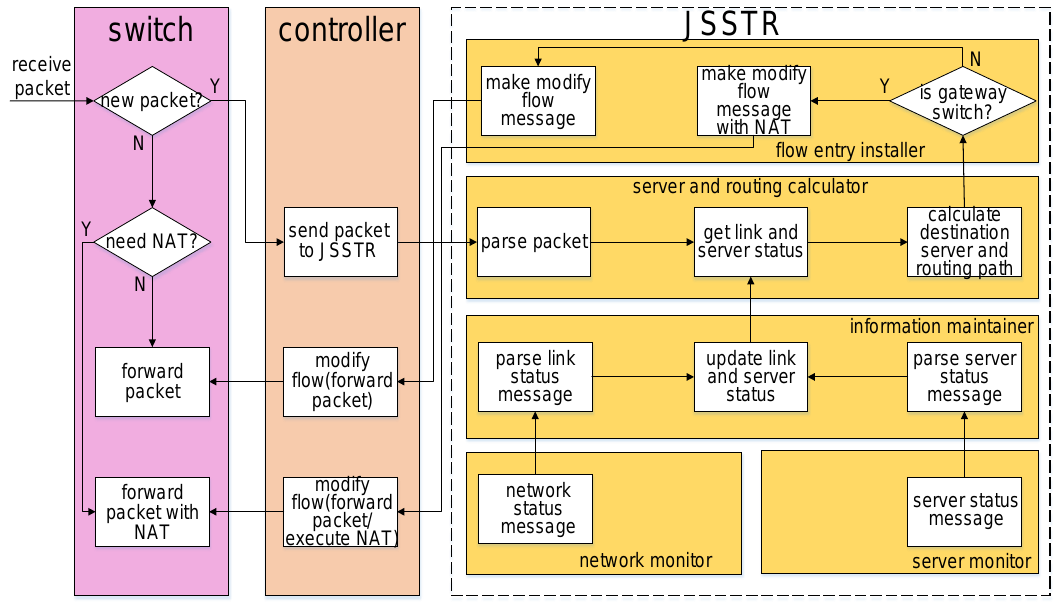
Figure 4. The implementation of the Joint Server Selection and Traffic Routing (JSSTR)